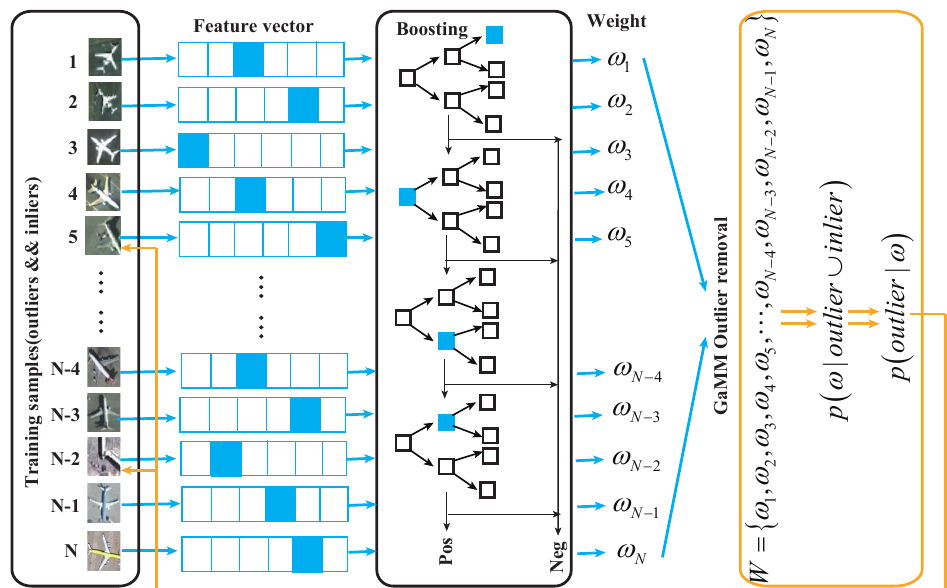
Figure 4. The detailed framework of classifier generation with outlier